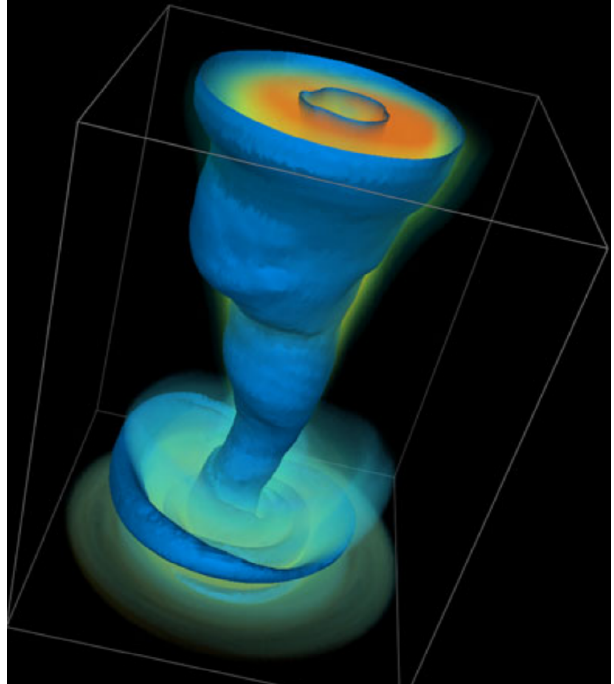
Figure 3. Jet launching simulation applying 3D GR-MHD. Shown is the volume rendering of the internal energy density (log scale) for the relativistic black hole jet within a box of 350 × 350 × 1000 black hole gravitational radii R g after t = 4000 time units t g = R g / c . Only the jet, not the counter jet, is shown, and fragments of the perturbed disk wind. The jet reaches Lorentz factors of Γ half-opening angle of Θ jet (cid:39) 5 ◦ . Figure taken from Reference [77], with kind permission of J. McKinney and by permission of Oxford University Press on behalf of the Royal Astronomical